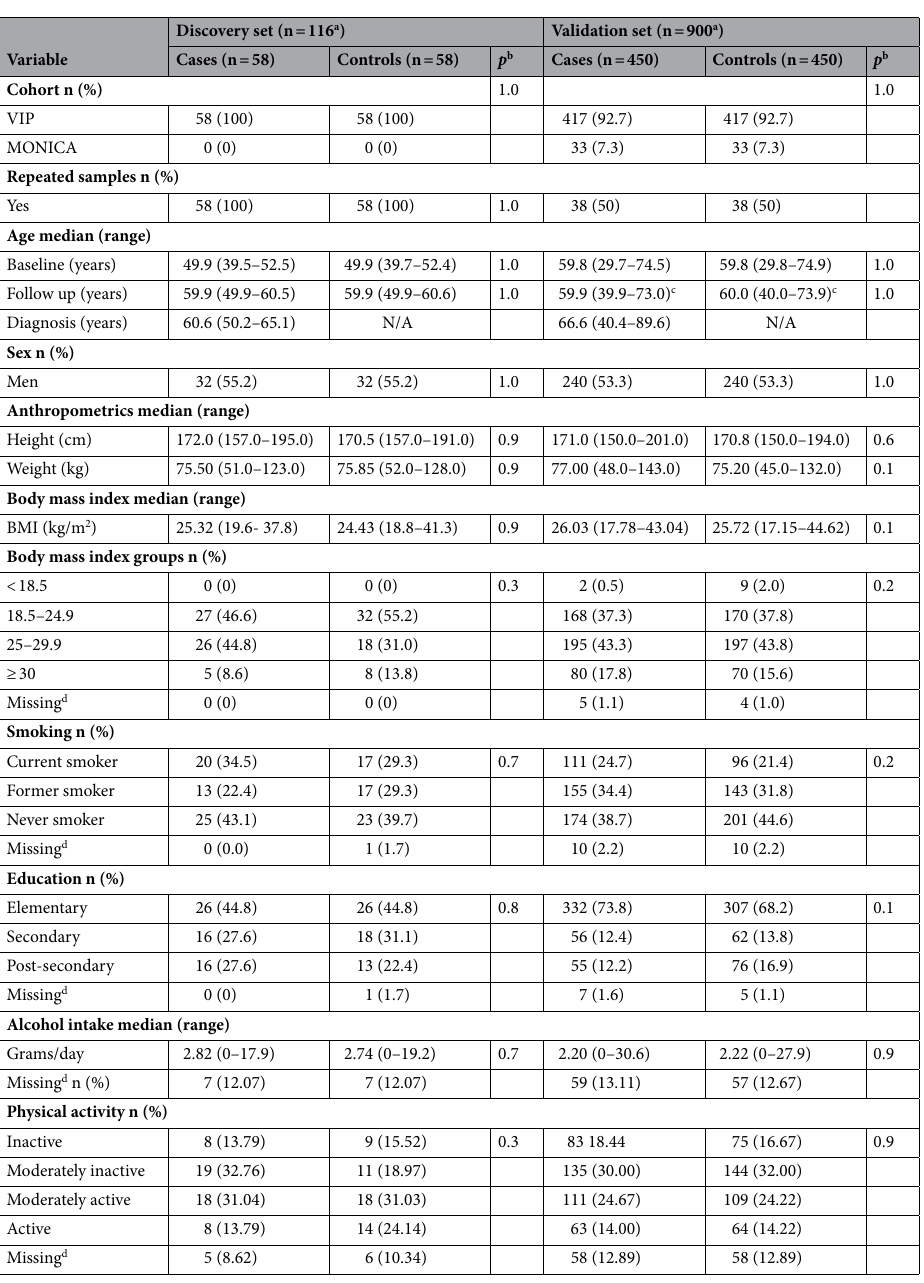
for continuous variables, Chi-Square tests for categorical variables. c Includes 38 case control pairs with follow up samples. d Missing category not included in the statistical